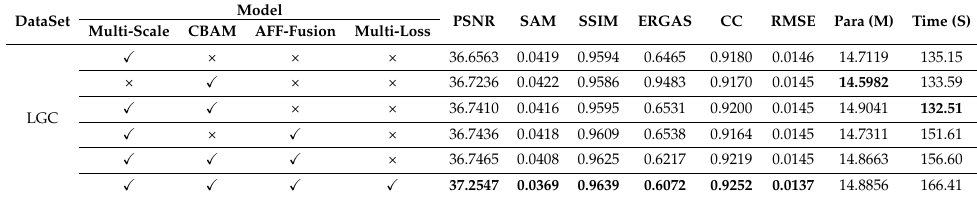
Table 4. Ablation experiments on LGC